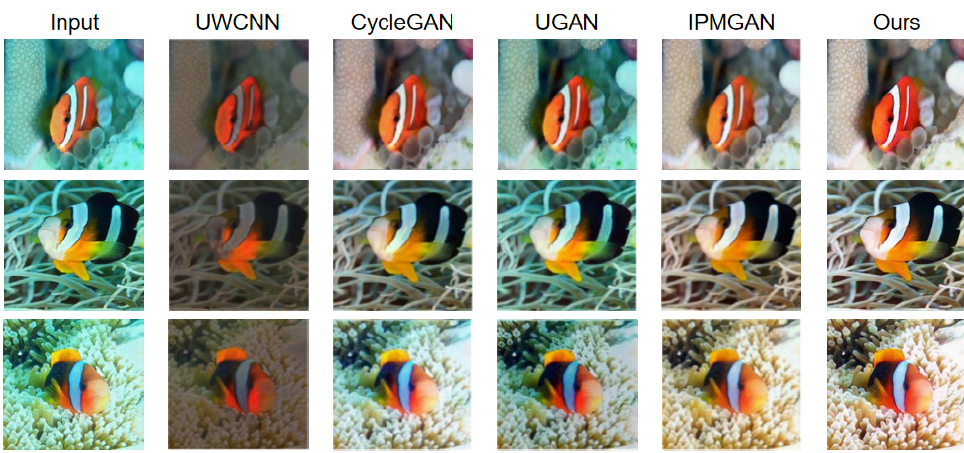
Figure 8. Generated results of the ImageNet test set.